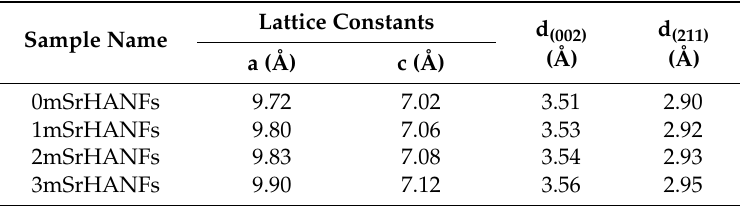
Figure 3. X-ray diffraction (XRD) patterns of ( a ) 0mSrHANFs, ( b ) 1mSrHANFs, ( c ) 2mSrHANFs, and ( d ) 3mSrHANFs. ( : CaO; : HAp/Sr-HAP; : CaCO 3 ). Table 3. Lattice constants, interplanar spacing for (211) and (002) diffraction of the mSrHANFs. (a and c: lattice constants; d:interplanar spacing).